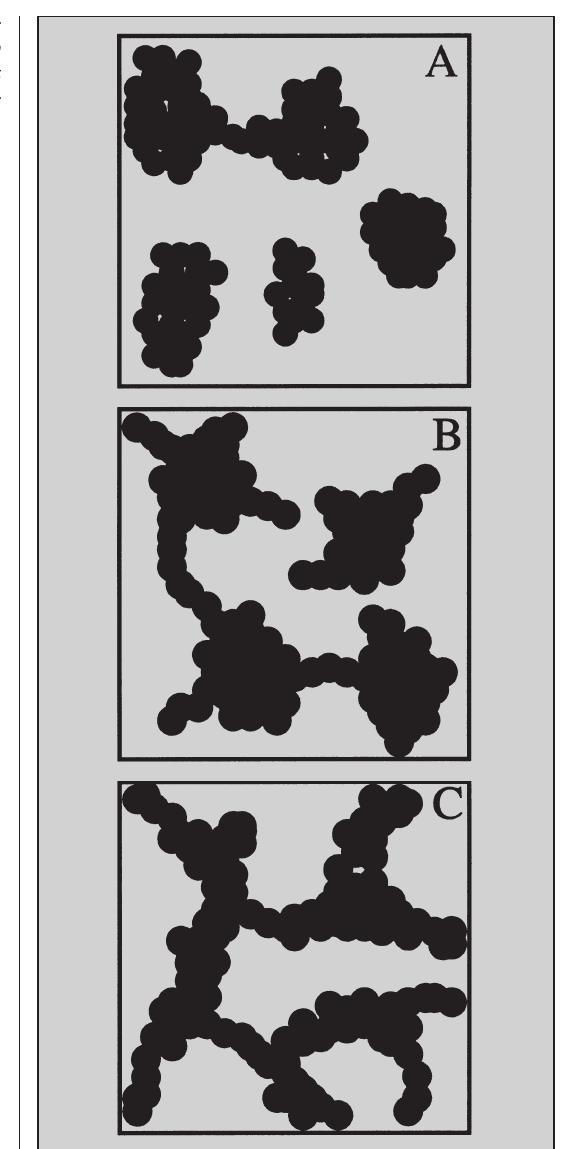
Figure 6: A schematic